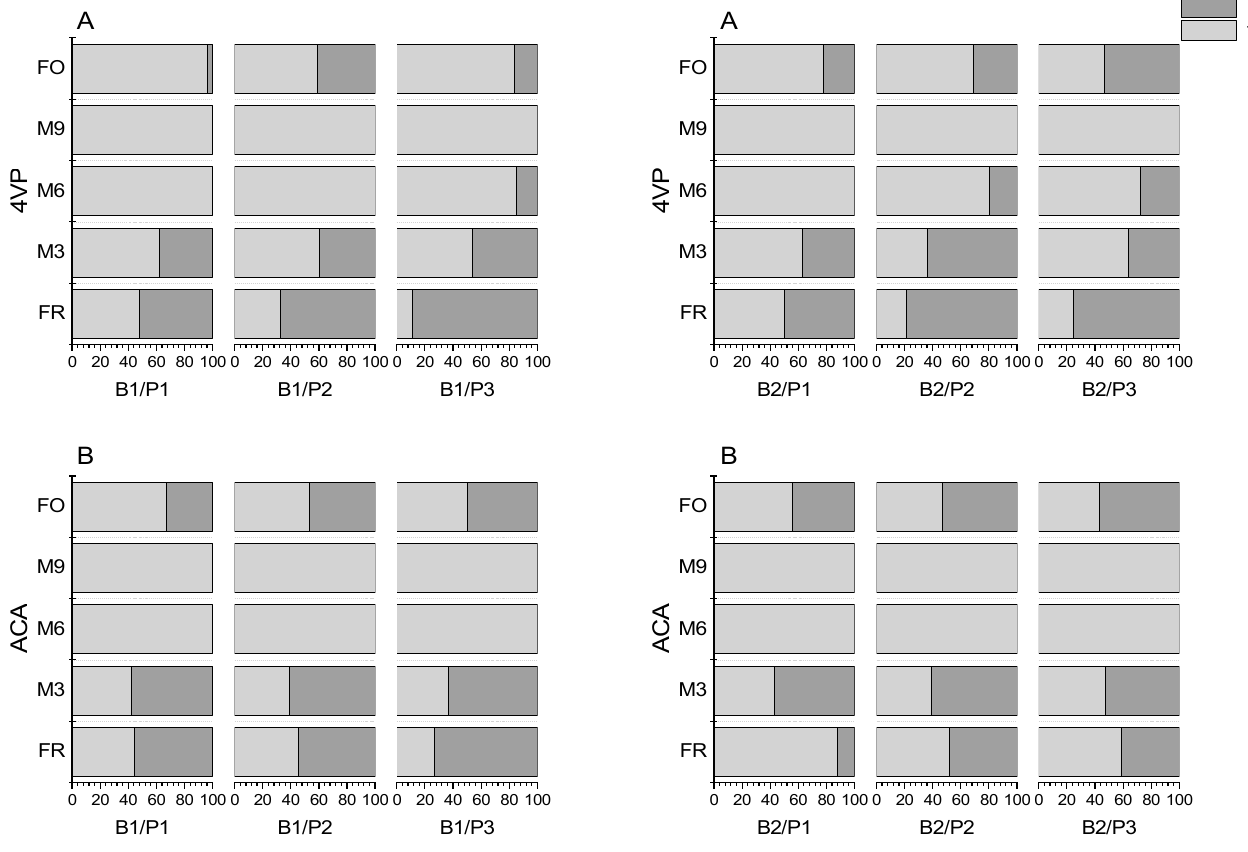
Figure 5. Ratio of sum of free and bound state aldehydes assessed by ( A ) 4VP and ( B ) ACA (B1: barley variety 1; B2: barley variety 2; P1: low proteolytic malt modification; P2: medium proteolytic malt modification; P3: high proteolytic malt modification).